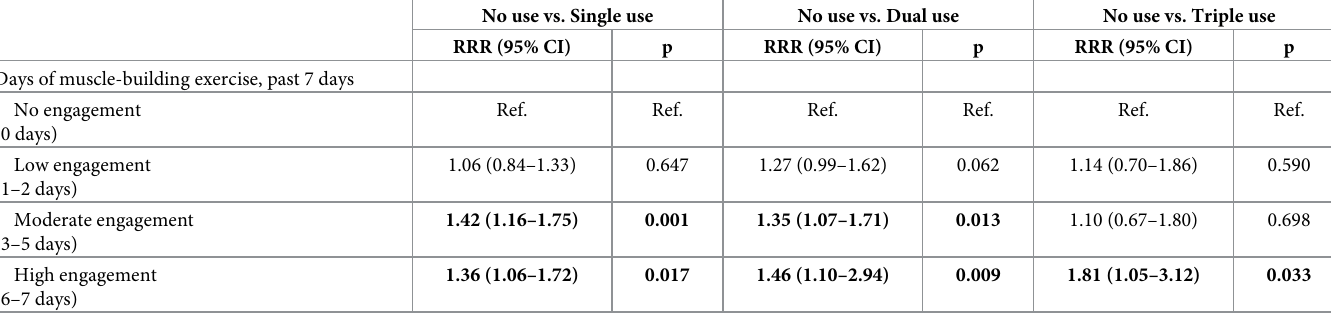
Table 2. Associations between muscle-building exercise and concurrent substance use among participants from the 2019 Youth Risk Behavior Survey (N = 8,474). No use vs. Single use No use vs. Dual